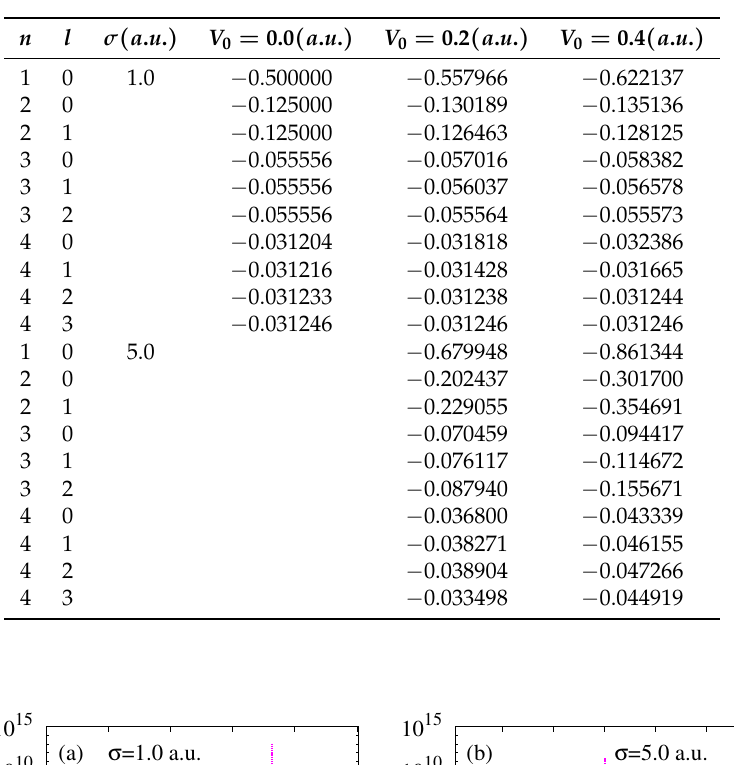
Table 5. First few energy levels of a hydrogen atom under the effect of a Gaussian potential and loose spherical confinement for r 0 = 50 a.u. and for various values of σ and V 0 .